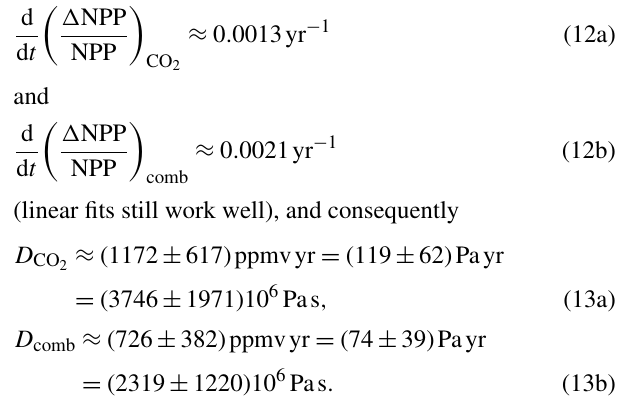
refers to O’Sullivan et al. (2019), who consider 2